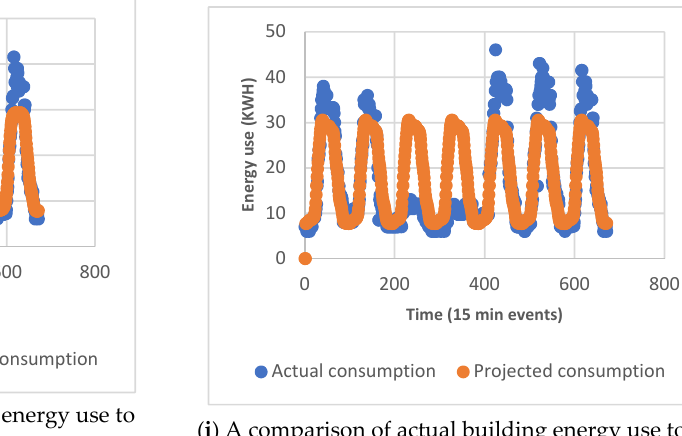
( h ) A comparison of actual building energy use to an ANN prediction of building energy use trained using eight neurons.